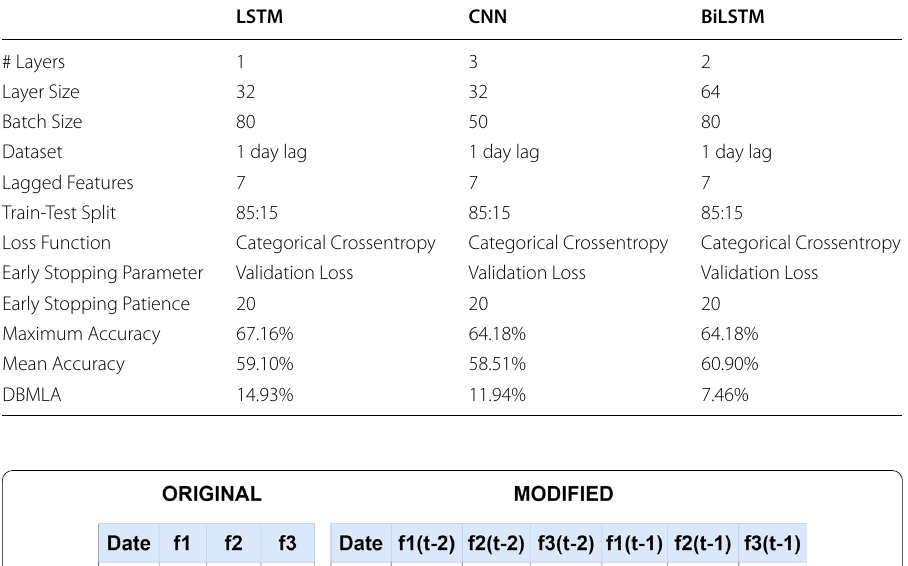
Table 2 Hyperparameters for the best models for predicting price direction DBMLA - Difference between Maximum and Lowest Accuracies LSTM